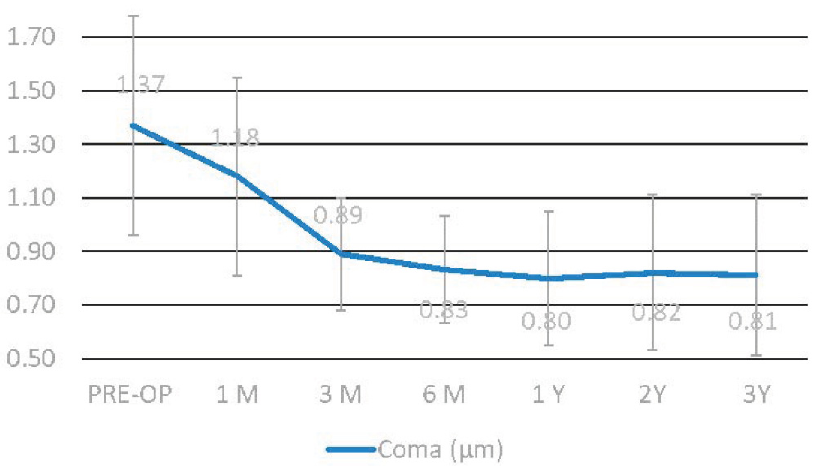
Figure 4. The coma value showed a statistically significant improvement at the sixth month ( ∆ − 0.54 µm ± 0.2), continuing thereafter.